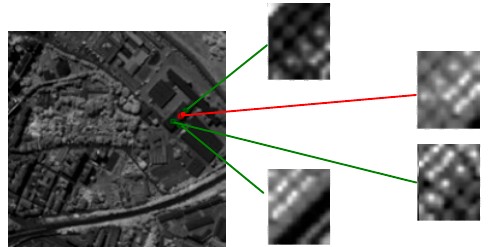
Figure 2. Some patch structures of the Pavia Centre data. Four areas are enlarged to better show the similarities of different patches. The area marked by the red box represents a test patch, and the ones marked by three green boxes are the neighboring patches of the test patch.